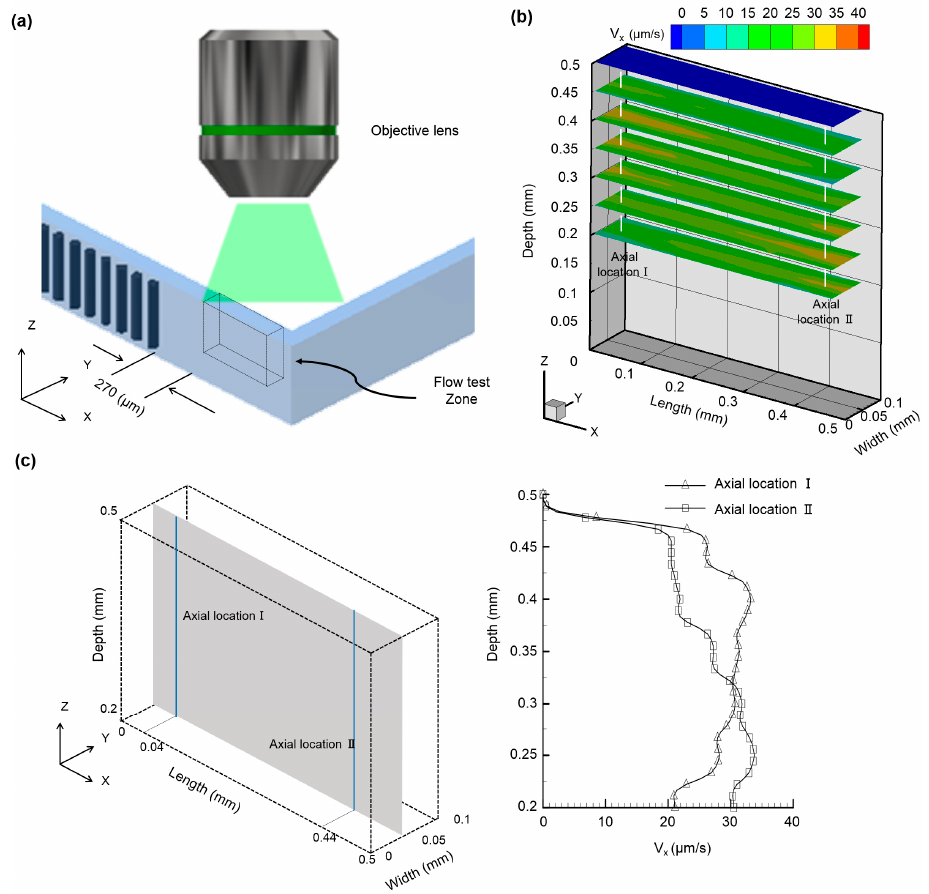
Figure 5. ( a ) Schematic illustration of the microfluidic device depicting the observation zone, which is situated at a distance of 270 µ m from the terminally located artificial cilia; ( b ) Calculated ensemble streamwise velocity distribution of the six selected horizontal planes along the depth of the microfluidic device, situated at distances of 200 µ m, 250 µ m, 300 µ m, 350 µ m, 400 µ m, 450 µ m, 500 µ m, respectively, from the bottom of the microfluidic device. Two different velocity profiles were evidenced at two axial locations situated at distance of 310 µ m (Axial location I) and 710 µ m (Axial location II) away from the rearmost artificial cilia; ( c ) Quantified instantaneous velocity profiles at the two different axial locations (i.e., axial location I and axial location II) of the observation zone along the vertical mid plane of the channel